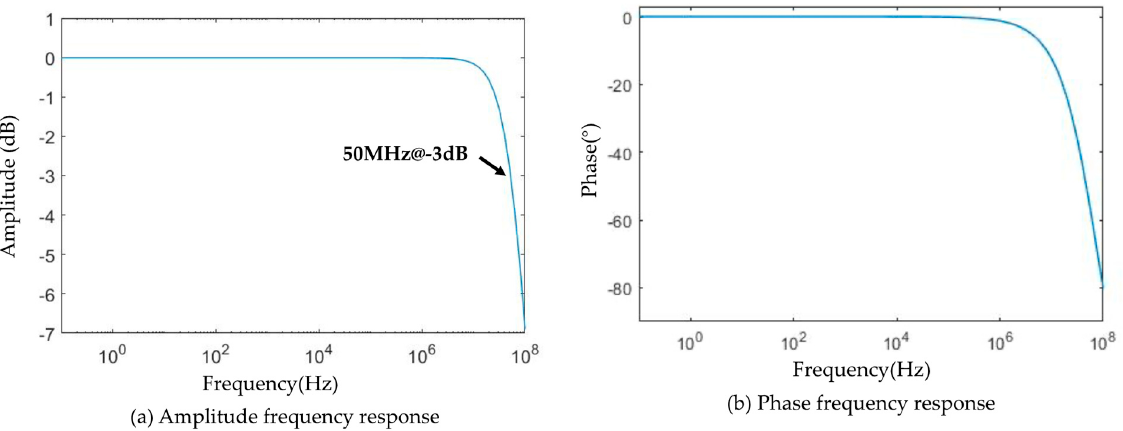
Figure 13. The high-frequency cut-off frequency of the sensor is 50 MHz.